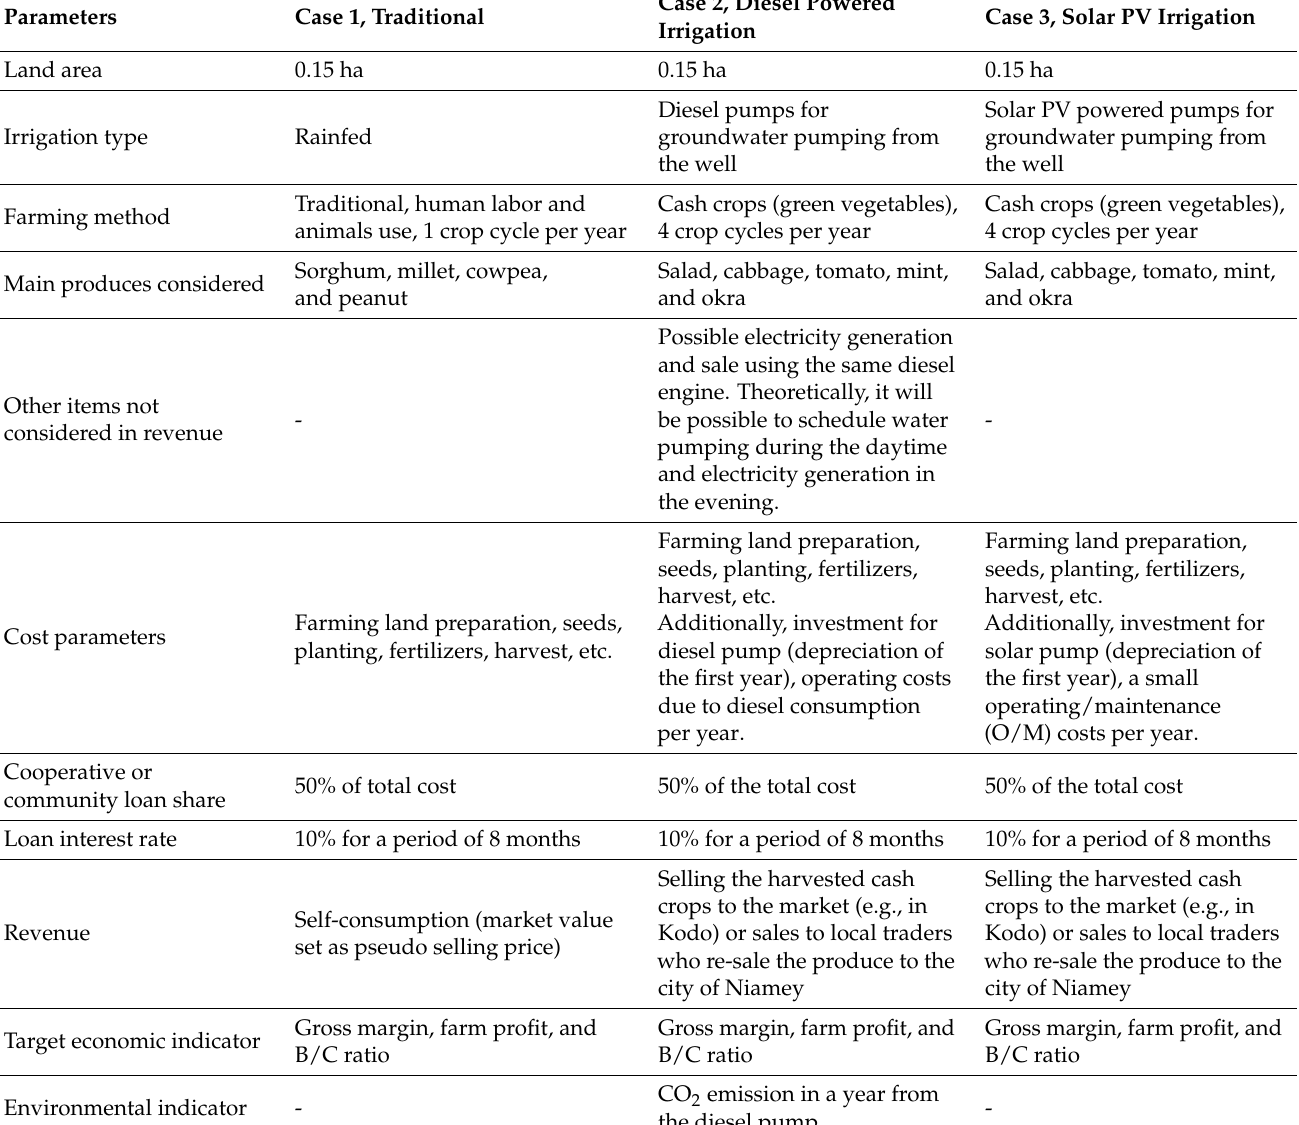
Table 1. Basic assumptions for cases 1–3 (traditional farming, diesel, and solar